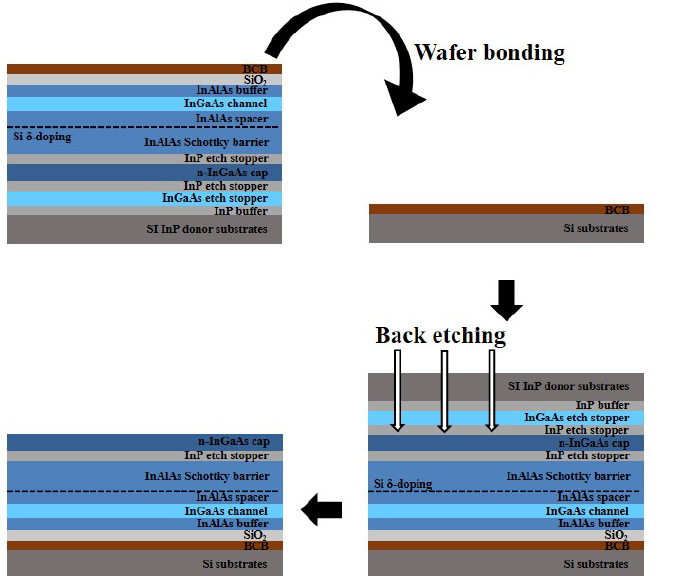
Figure 1. Process flow for the InGaAs HEMTs structures layers on Si substrates fabrication by using adhesive wafer bonding